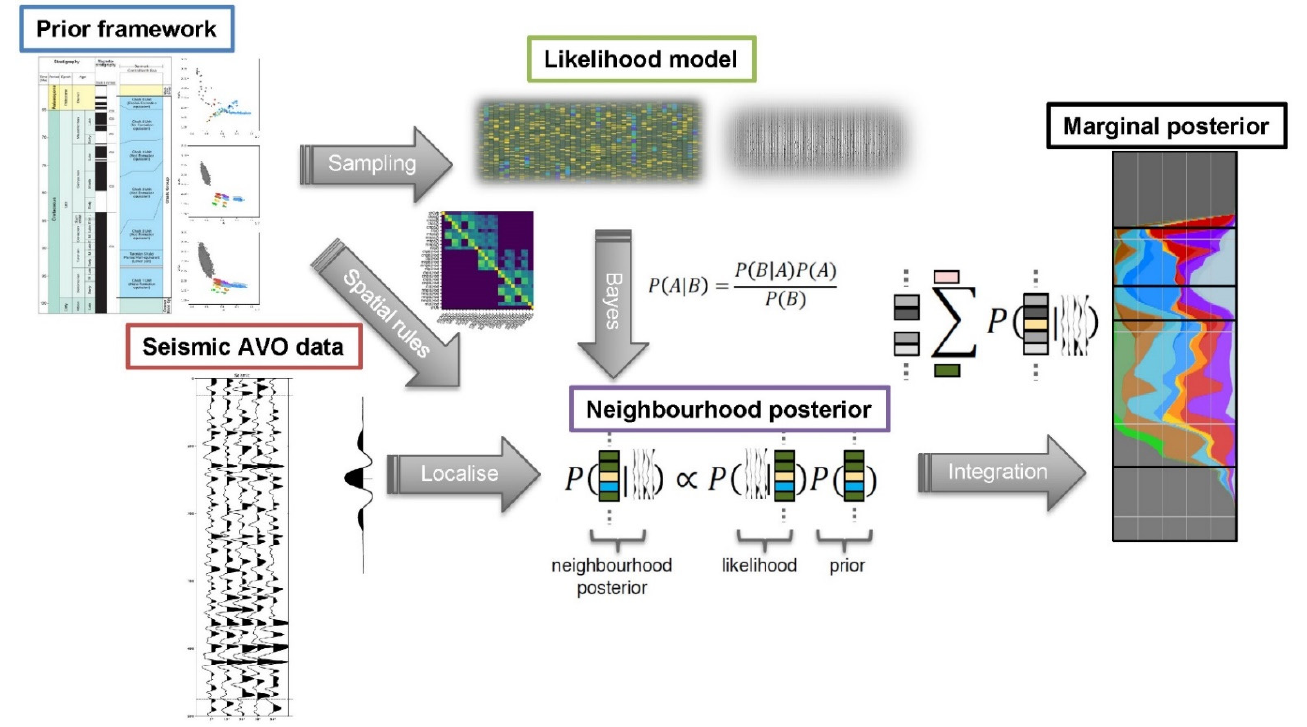
Figure 3. Schematic workflow of the DPI inversion (adapted from Goodway et al. [17]).